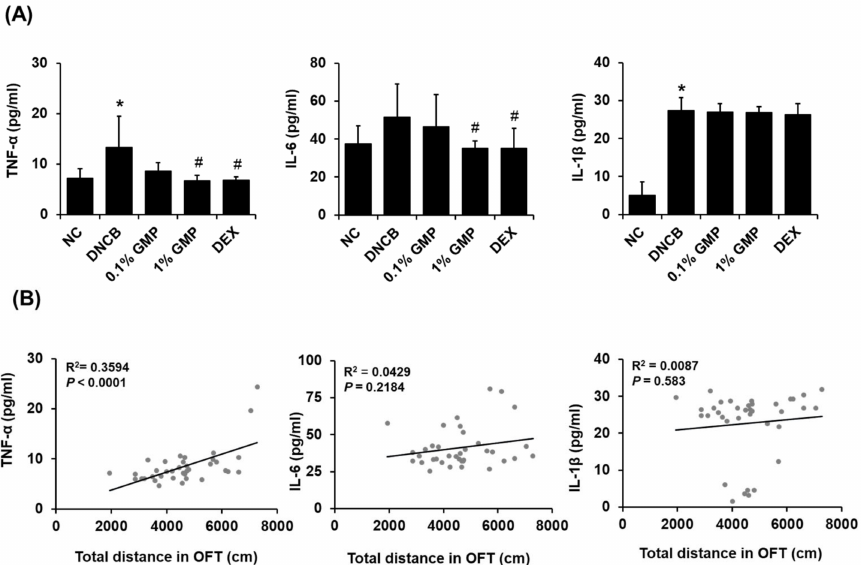
Figure 5. Effect of GMP on the inflammatory cytokine levels in the PFC in DNCB-treated BALB/c mice. ( A ) Inflammatory cytokines TNF- α , IL-6, and IL-1 β levels in the PFC area of the brain. ( B ) Correlation between inflammation cytokine and total distance in OFT. Data represent the means ± SDs. * p < 0.05 vs. the NC group, # p < 0.05 vs. the DNCB group.